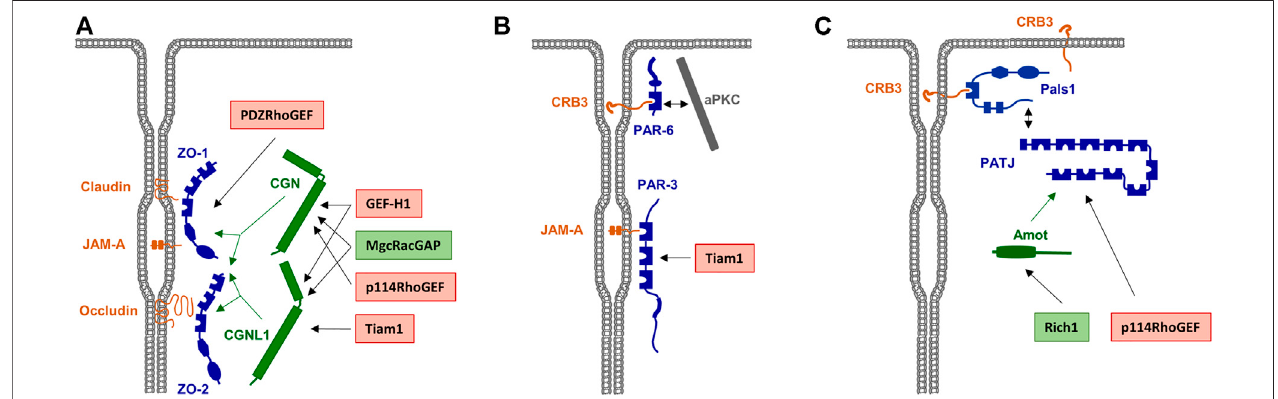
FIGURE 3 | Scaffolding proteins for RhoA family GEFs and GAPs a the TJs. (A) Rho family GEFs and GAPs associated with the Zonula occludens (ZO) complex. ZO-1andZO-2directlyinteractwithvariousintegralmembrane proteinslikeOccludin,ClaudinsandJAM-A.RhofamilyGEFsandGAPscandirectlyinteractwiththeZO complexbut also indirectly through theadapter proteins cingulin(CGN) and cingulin-like 1(CGNL1),which interact withZO proteins asindicated bygreen arrows. GEFs and GAPsare indicated in red and green boxes, respectively. (B) RhoA GEFsassociated withthe PAR — aPKC complex. PAR-3 directly interacts with JAM-A. The RhoA GEF Tiam1 directly interacts with PAR-3. (C) Rho family GEFs and GAPs associated with the CRB3 — Pals1 — PATJ complex. PATJ is associated with the membrane through Pals1 and CRB3. The interaction of Rich1 with PATJ is mediated by Amot, p114RhoGEF directly interacts with PATJ.